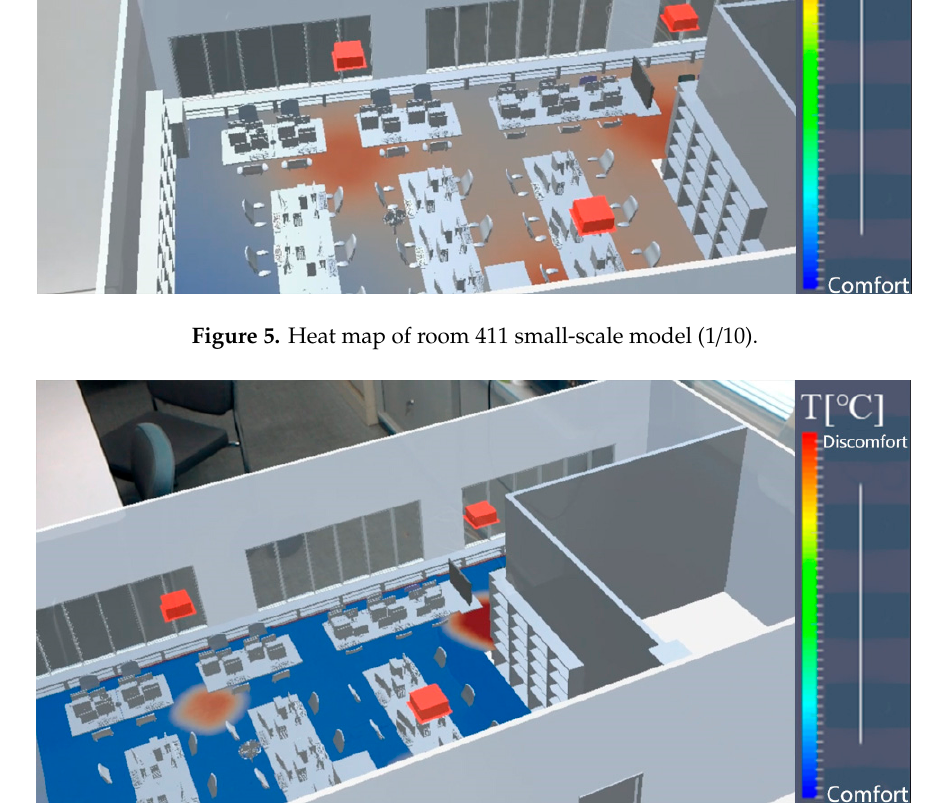
Figure 6. Comfort map of room 411 small-scale model (1/10).